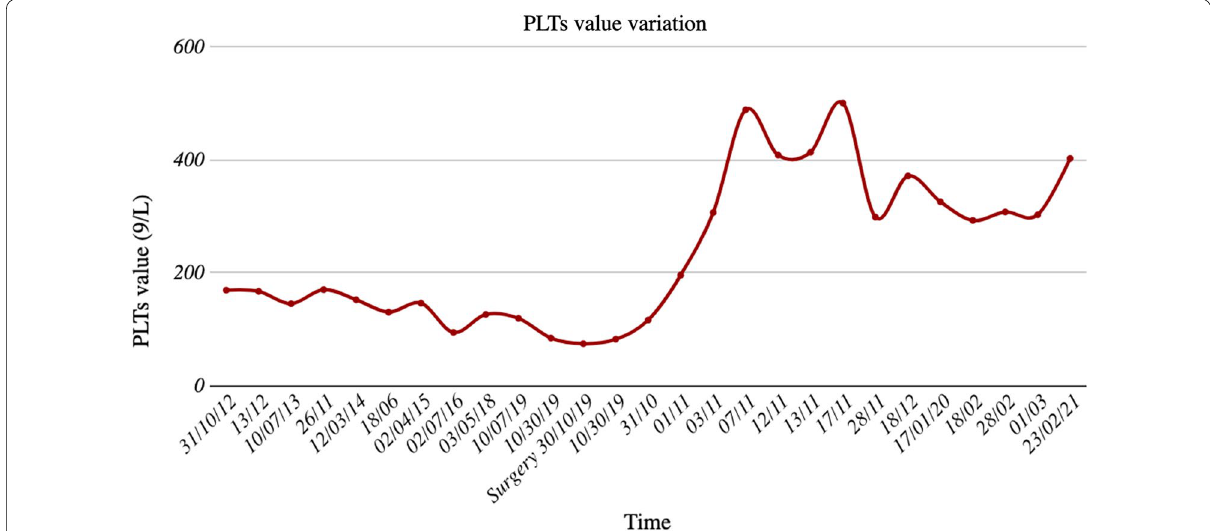
Fig. 4 Variation of platelets value in time, in relation to urgent surgical